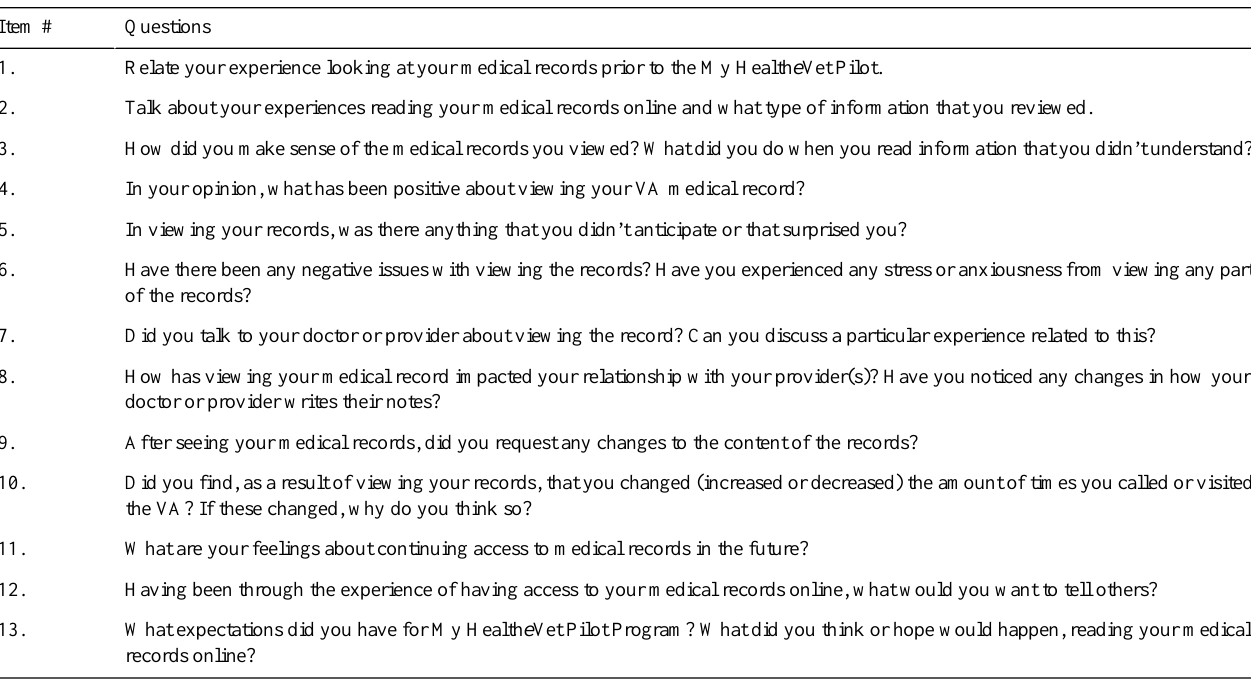
Table 1. Focus group interview